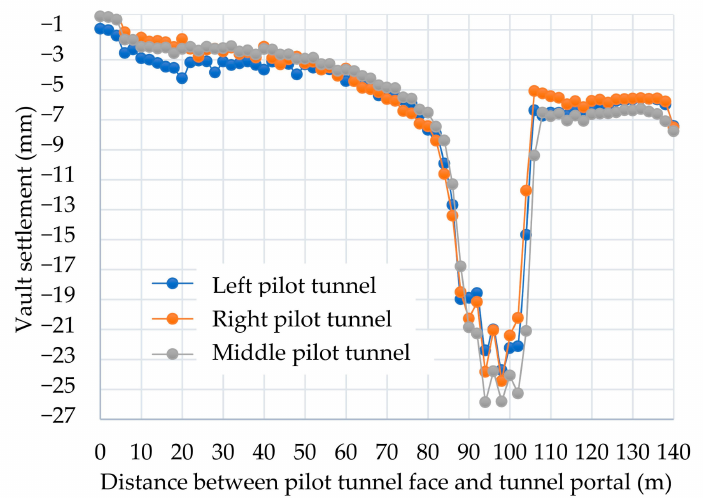
Figure 12. Vault settlement of three pilot tunnels during pilot tunnel excavation.